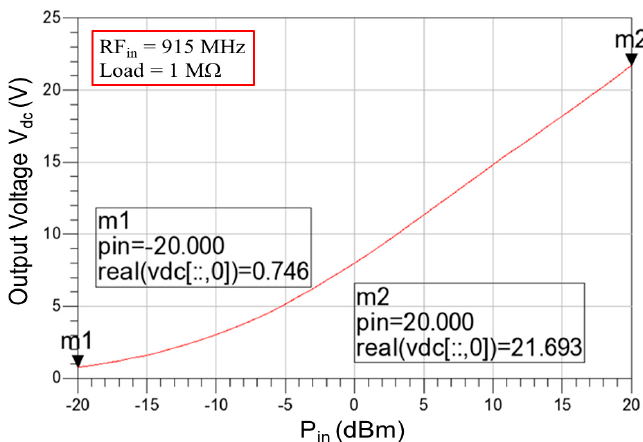
Figure 9. Simulated output voltage of the RF-DC rectifier with respect to the input power from − 20 dBm to +20 dBm.